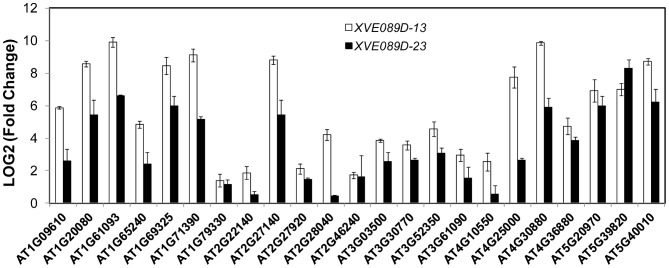
NAC089 regulates many downstream genes.Expression of down-stream genes identified through microarray analysis was examined with qRT-PCR in two lines of NAC089D-MYC plants. Fold change is the gene expression level of plants treated with beta-estradiol (BE) for 16 hr divided by that of plants treated with DMSO (solvent control), both of which were normalized to the expression of actin. Bars depict SE (n = 3). The fold change for each gene is significant (P<0.01) in line XVE089D-13.